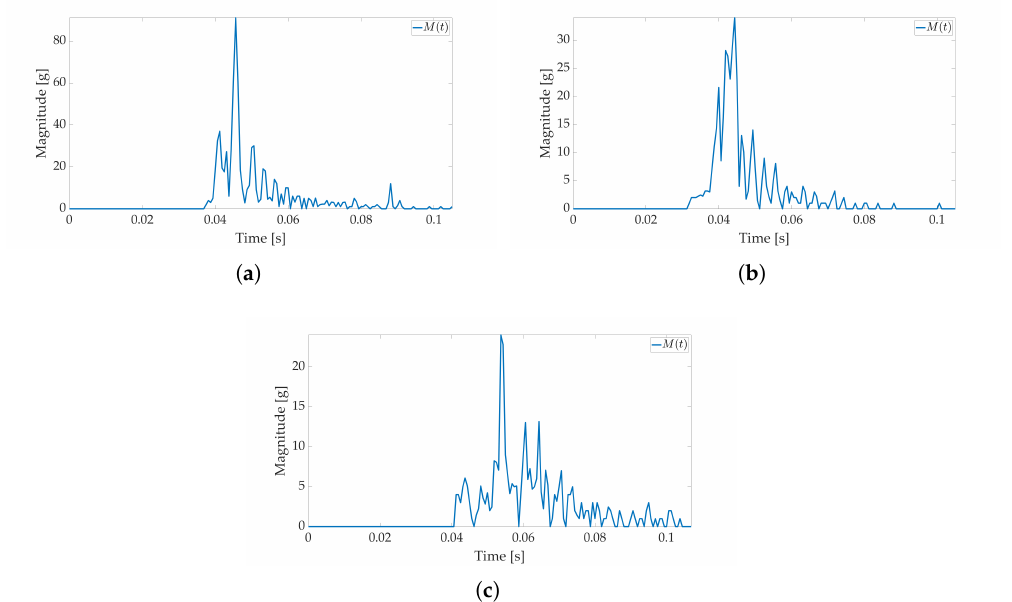
Figure 14. Shock detection values for weight drop onto the stationery package (1600 Hz with FIFO). The weight falls from the different heights listed below. Acceleration magnitude waveform measured inside the package on figures ( a ) (100 cm), ( b ) (50 cm), ( c ) (20